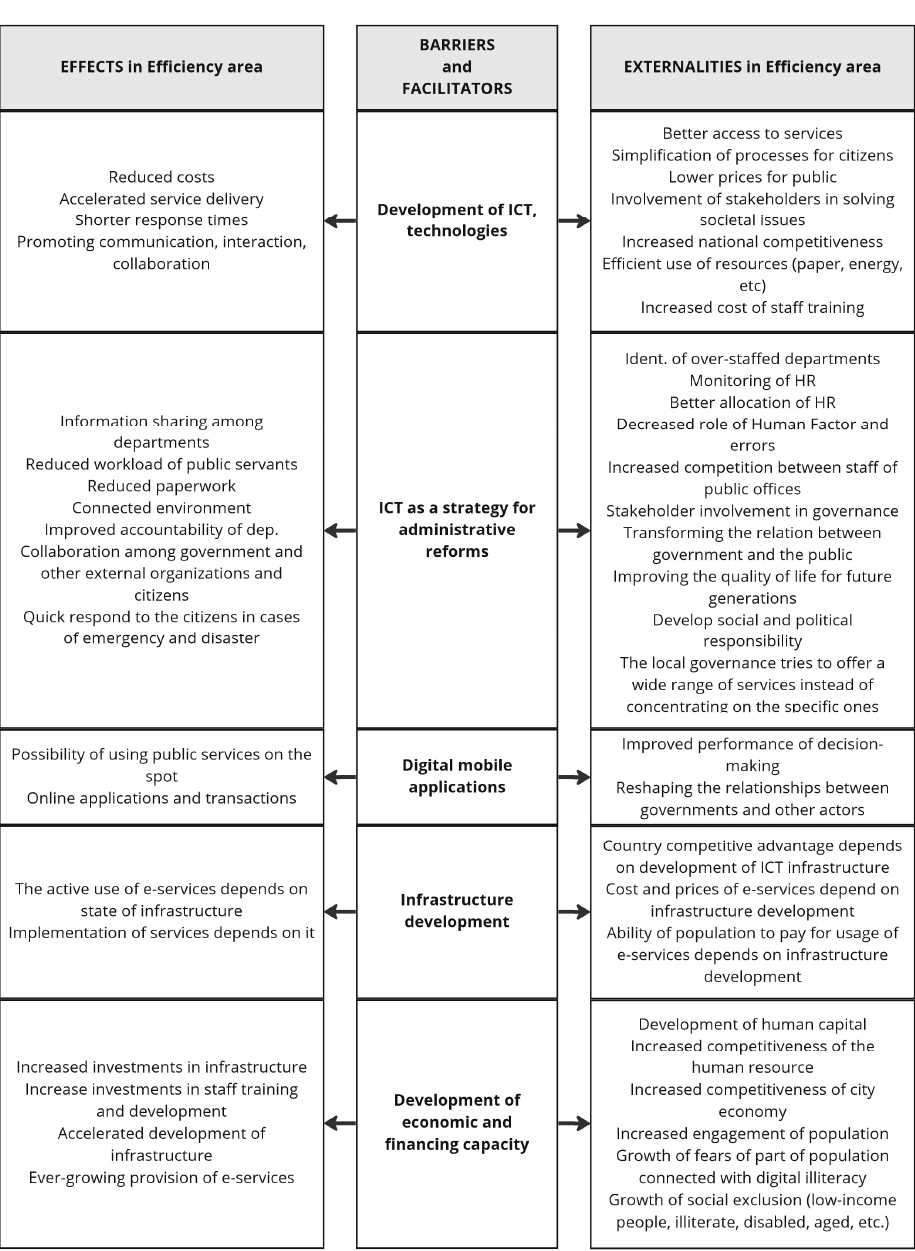
Figure 4. Barriers or facilitators, effects, and externalities of smart governance implementation in the E ffi ciency area. Source: generated by the authors.